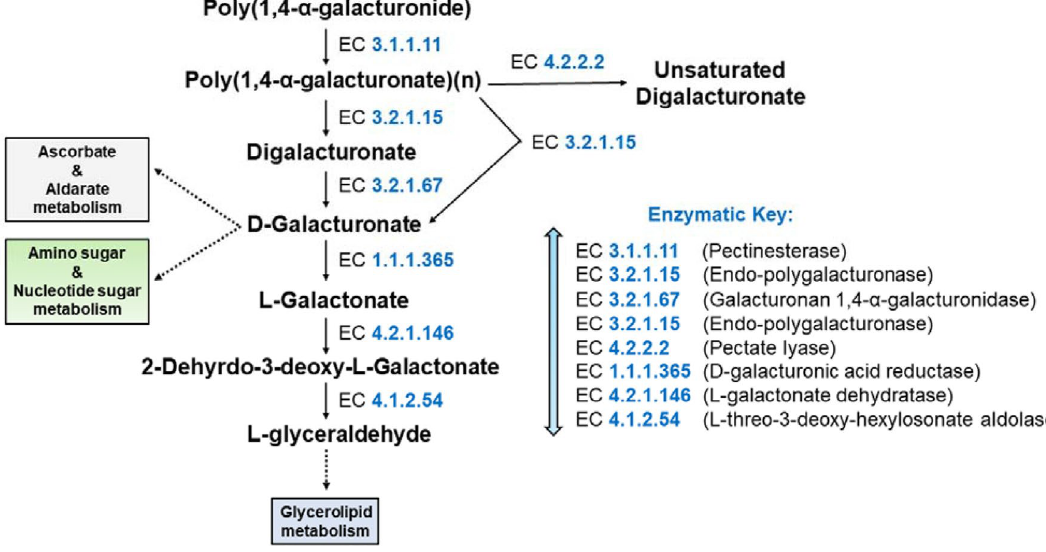
Figure 8. Pentose and glucuronate interconversion depicts the route enzymes of plant cell wall degrading